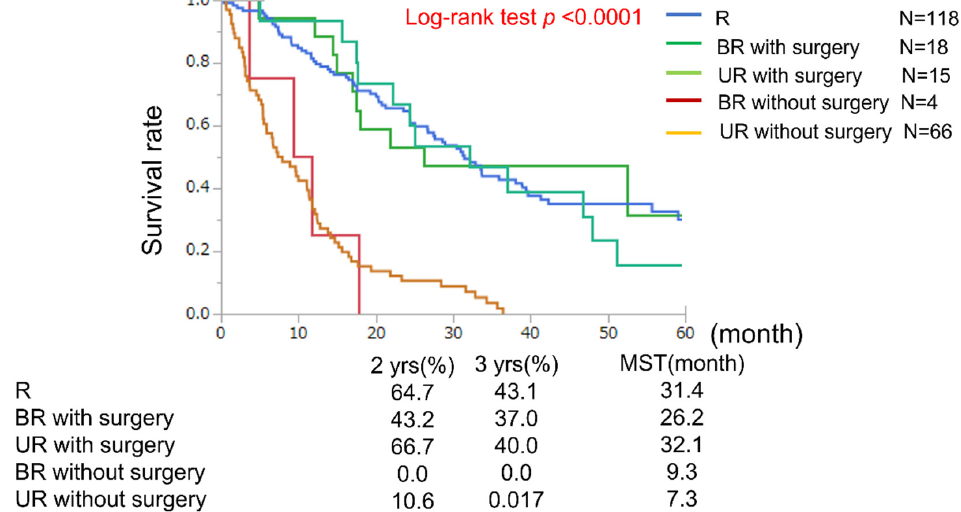
Figure 2. Overall survival classified by resectability in resection cases. The curve for the patient groups in which R—resectable, BR—borderline resectable with surgery, and UR—unresectable with surgery significantly differed from that for the BR and UR groups without surgery ( p < 0.0001).